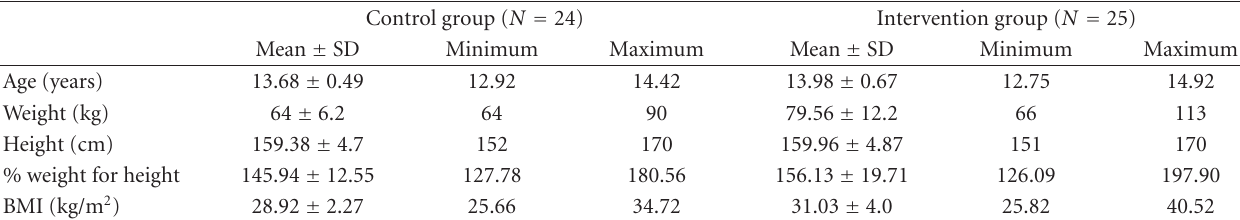
Table 1: Baseline characteristics of participants.